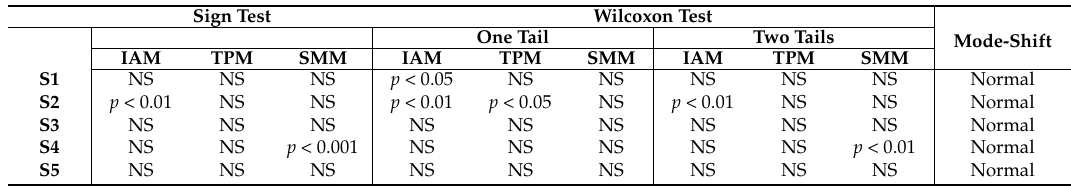
Table 2. Results of the statistical tests examining evidence for recent bottlenecks in the five Reticulitermes flavipes genetic clusters identified by S TRUCTURE .